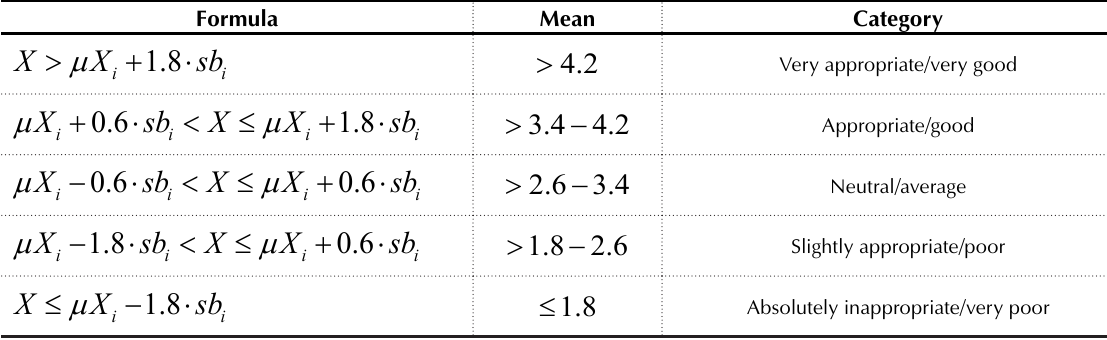
Table 1. Conversion of quantitative data to qualitative